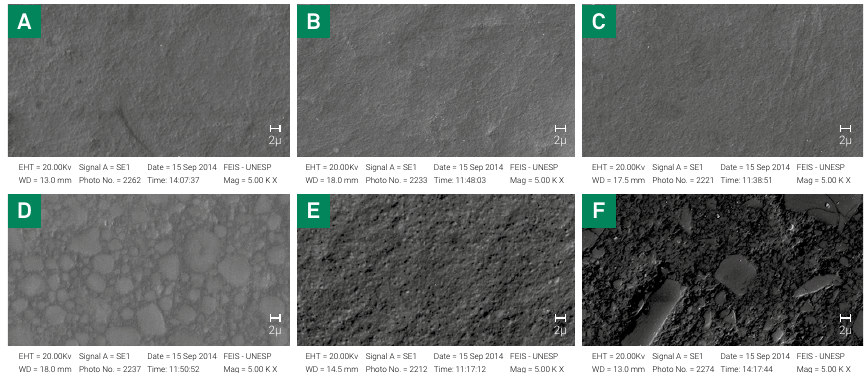
Figure 2. Representative scanning electron micrographs of composites after submission challenges. (A) Estelite Σ Quick, (B) Durafill VS, (C) Renamel, (D) Filtek Z350 XT, (E) IPS Empress Direct, and (F) Charisma Diamond. Note different patterns of corroded resin matrix provided by the association of chemical and mechanical challenges. Original magnification 5000X. Gloss of composite before and after challenges